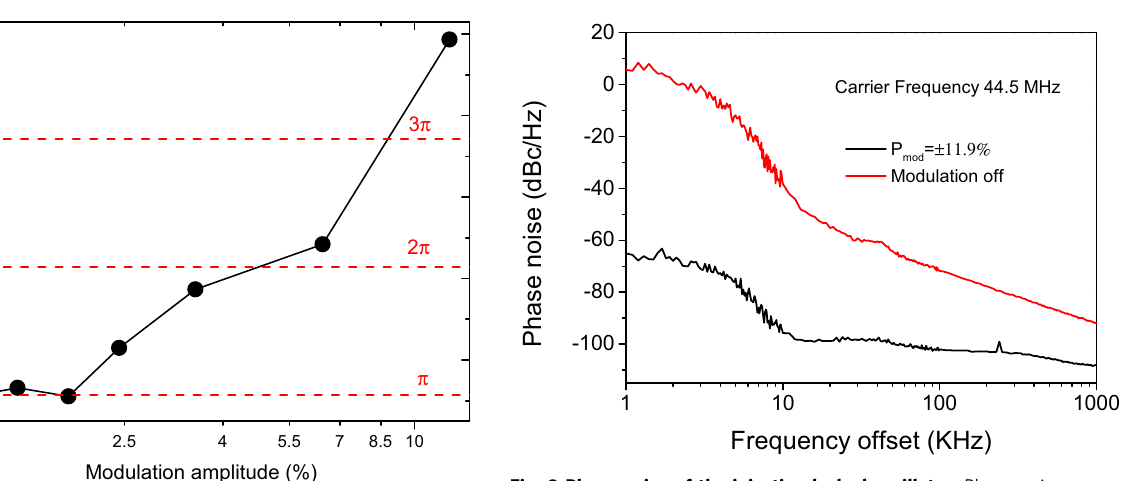
Fig. 9 Phase noise of the injection-locked oscillator. Phase noise measurements of the free-running self-pulsing (SP) oscillator (red curve) and of the injection-locked SP with a radio-frequency external tone at 44.5 MHz with modulation amplitudes P mod = ±11.9% (black